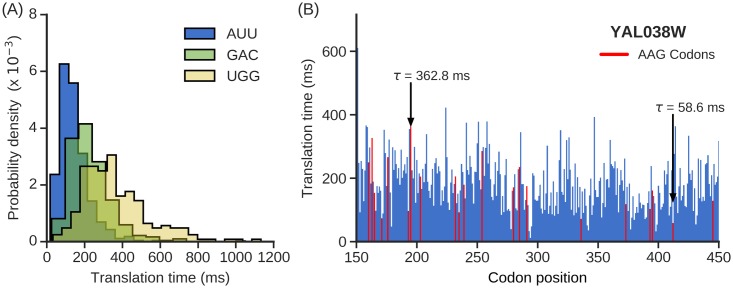
Wide variability in individual codon translation rates in vivo.(A) Probability density functions for translation times of AUU, GAC and UGG codons in Nissley dataset. Median translation times for AUU, GAC and UGG codon are 127, 208 and 331 ms, respectively. (B) The translation time profile of S. cerevisiae transcript YAL038W from Nissley dataset is shown between codon positions 150 and 450. AAG codon (colored red) is translated in 362.8 ms at the 196th codon position and in 58.6 ms at 413th codon position.